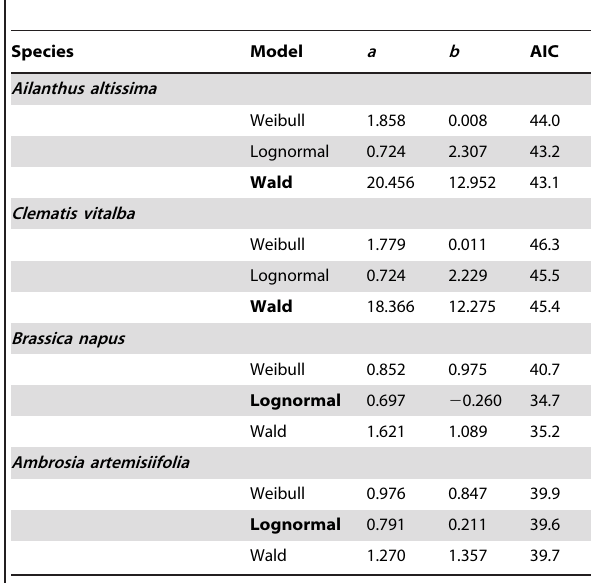
Table 3. Parameter estimates and AIC for different dispersal functions.